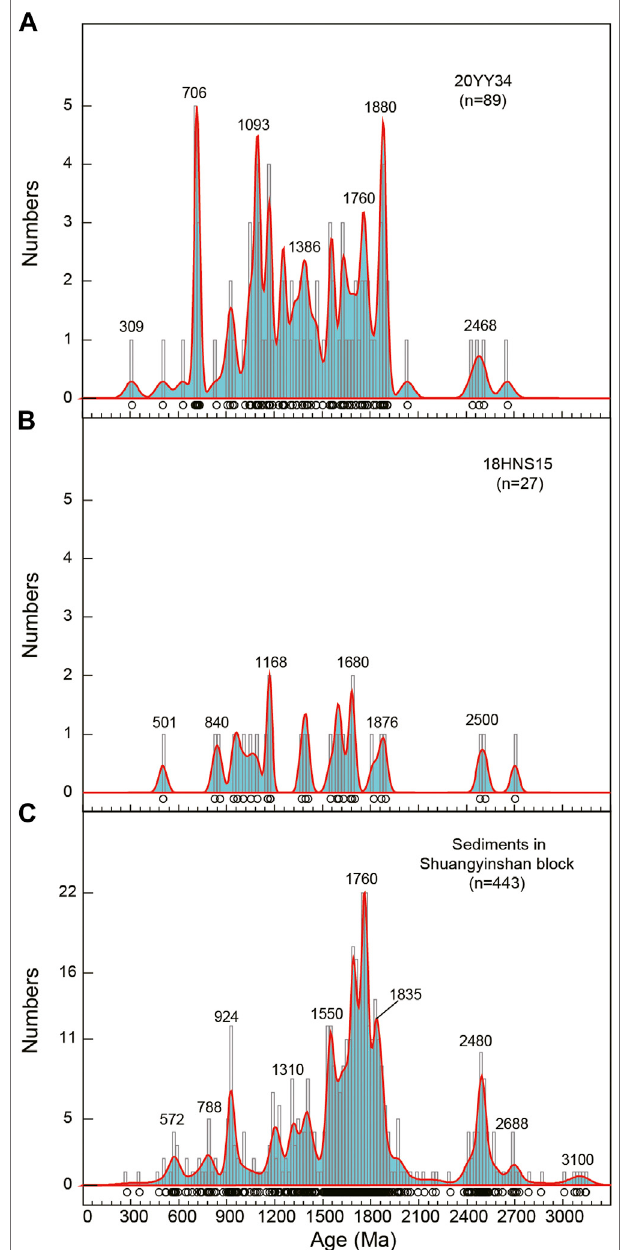
FIGURE 12 | Comparison of probability plots for zircon U-Pb ages of sedimentary rocks. (A and B) are from the sedimentary rocks of the Huaniushan complex in the Beishan orogen, (C) is from the metasedimentary rocks of Shuangyinshan block in the Beishan orogen (Song et al., 2013; Ao et al., 2016; Song et al., 2016).